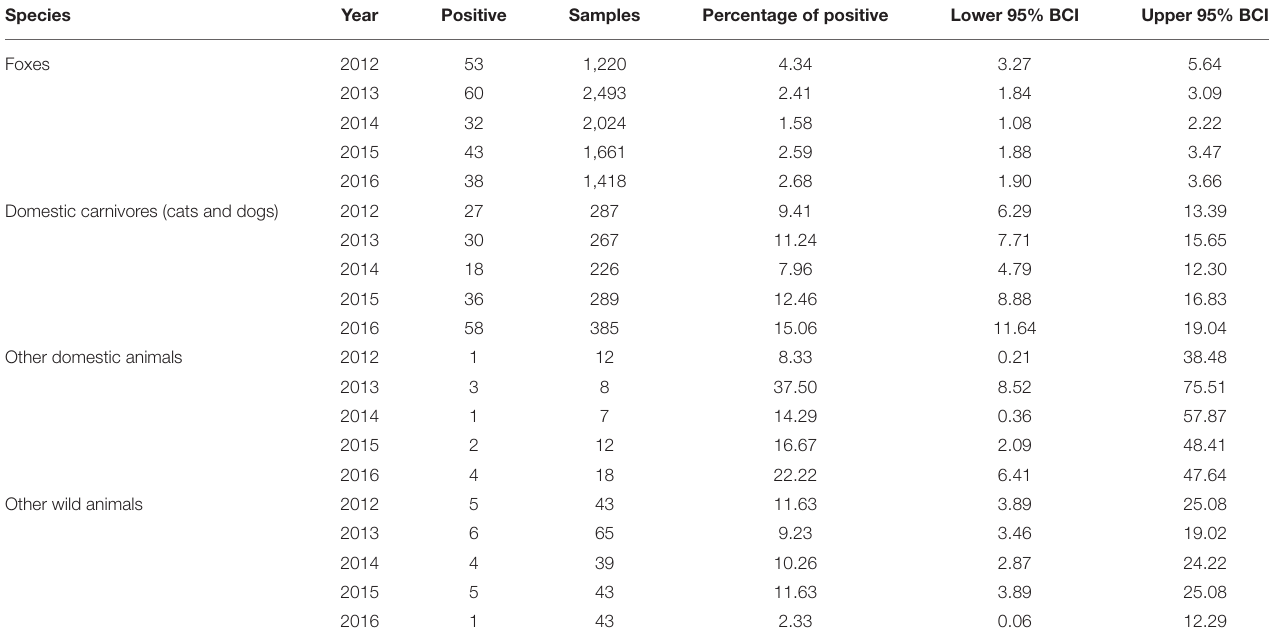
Total number of cases/species category is shown in gray shaded areas. TABLE 2 | Rabies cases by year (2012–2016) with 95% exact binomial confidence interval.